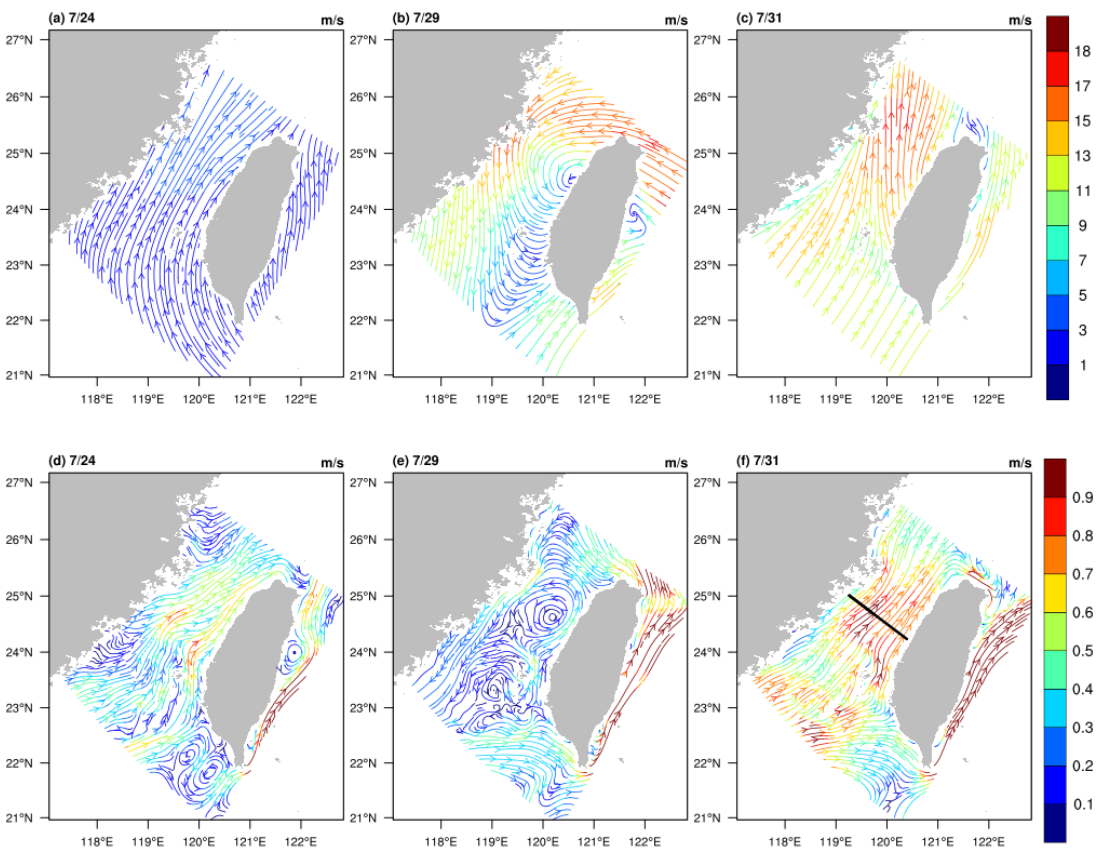
Figure 8. Top panels: daily averaged wind field from CCMP wind data from WRF simulation for the dates of ( a ) 24 July, ( b ) 29 July, and ( c ) 31 July. Bottom panels: daily averaged ocean surface currents from ROMS simulation for the dates of ( d ) 24 July, ( e ) 29 July, and ( f ) 31 July. Colours represent the velocity magnitude. The straight black line in ( f ) denotes the position of a cross-section analysed in Figures 9–13.